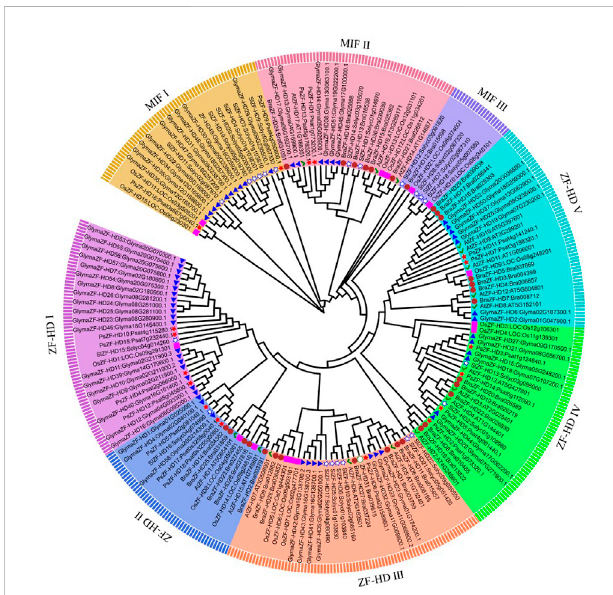
FIGURE 1 The phylogenetic tree of ZF-HD proteins from pea ( Pisum sativum, Ps), Arabidopsis ( Arabidopsis thaliana, At), Tamato ( Solanum lycopersicum, Sl), Soybean ( Glycine max,,Glyma ), Chinese cabbage ( Brassica rapa,Bra ) and rice ( Oryza sativa,Os ). The phylogenetic Tree members showed as blot and accompany a